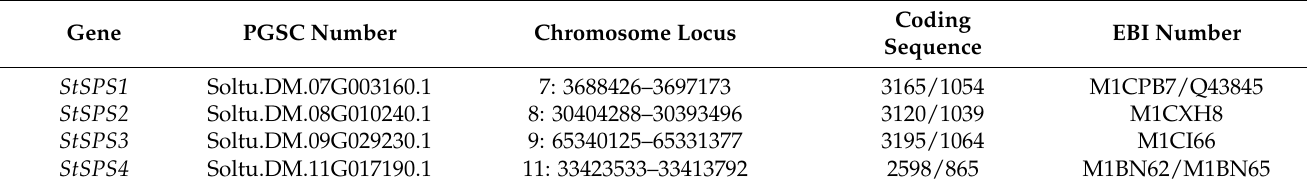
Table 2. Information of StSPS family members. PGSC is the potato genome database, while EBI is the European bioinformatics institute database. Coding sequence refers to the length of gene and protein sequences.